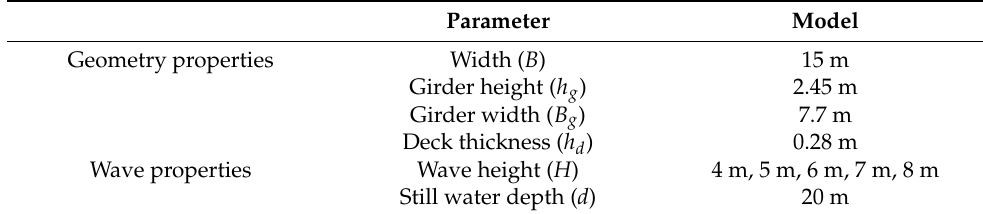
Table 4. The parameters of the simulation